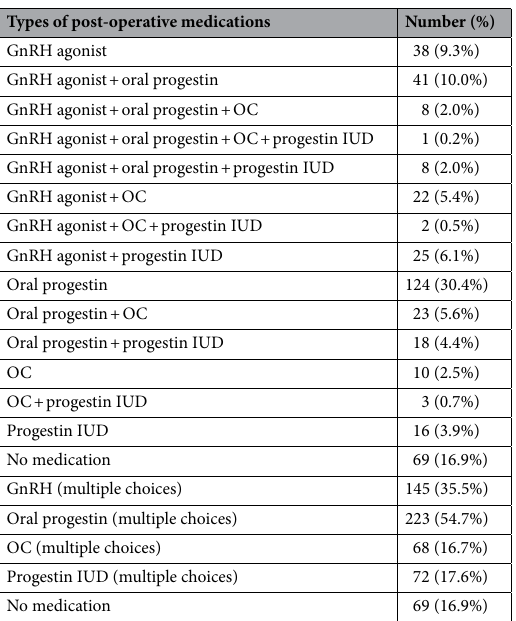
Table 2. Types of post-operative medications (n = 408). GnRH agonist, gonadotrophin releasing hormone agonist; OC, oral contraceptives; IUD, intrauterine device.